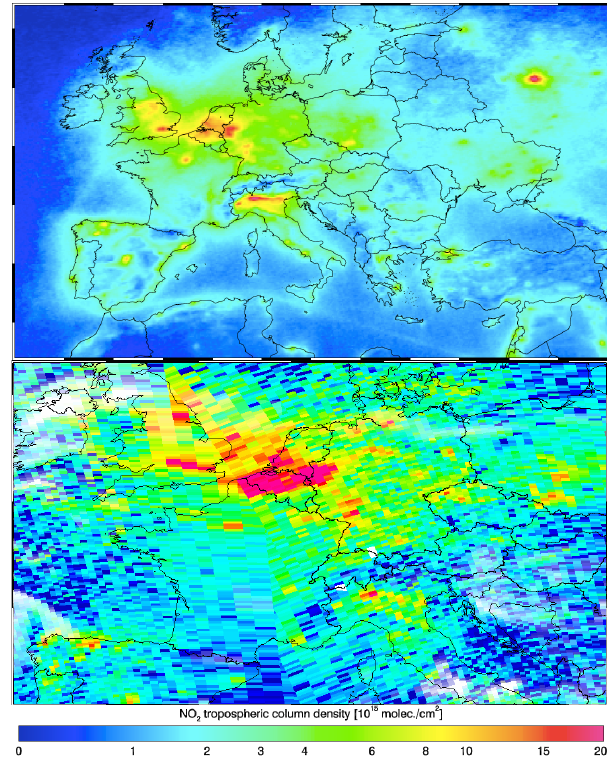
Figure 1. Measurements of the tropospheric NO 2 column over Eu- rope from the Ozone Monitoring Instrument (OMI) on EOS-Aura (Boersma et al., 2011). Top panel: yearly mean observation for 2005. Bottom panel: a sum of all observations available for assim- ilation on 1 day with little cloud cover (30 August 2005), showing the pixel size (13 × 24km at nadir) and the overlap between orbits at high latitude. The retrieved cloud fraction is used to fade out the measurements (white indicates 100% cloud